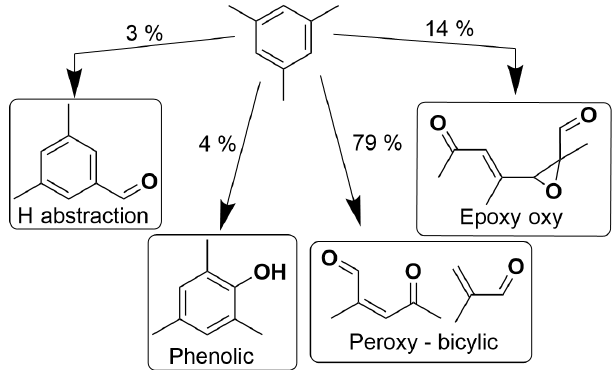
Figure 8. Schematic of OH-initiated oxidation pathways of 1,3,5- trimethylbenzene as included in MCM version 3.1, adapted from Metzger et al.